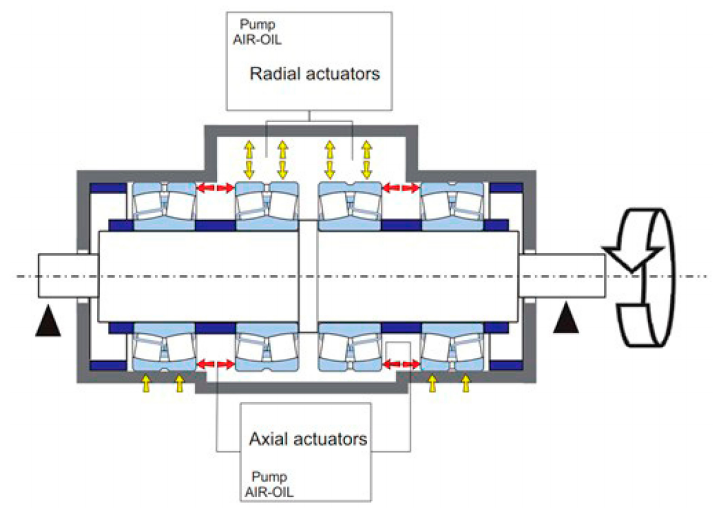
Figure 5. Scheme of the self-contained box [58]. Table 3. SKF CMS 2200T sensor specifications.